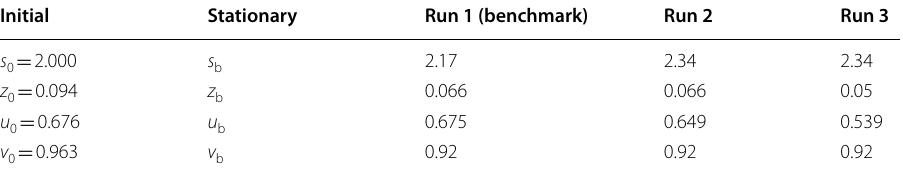
Table 17 Stationary magnitudes of the phase variables in the three simulation runs for L-2 Initial